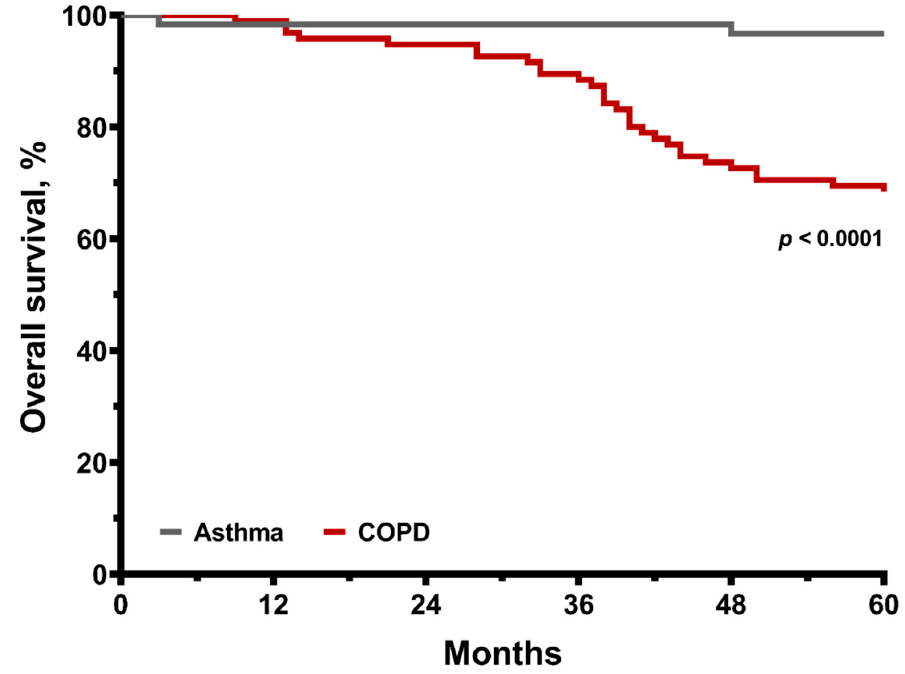
Figure 2. Kaplan–Meier survival curves for matched asthma and COPD cohort for five-year all-cause mortality. The p value is shown. Table 2. Factors associated with all-cause mortality at a five-year follow-up in a Cox regression